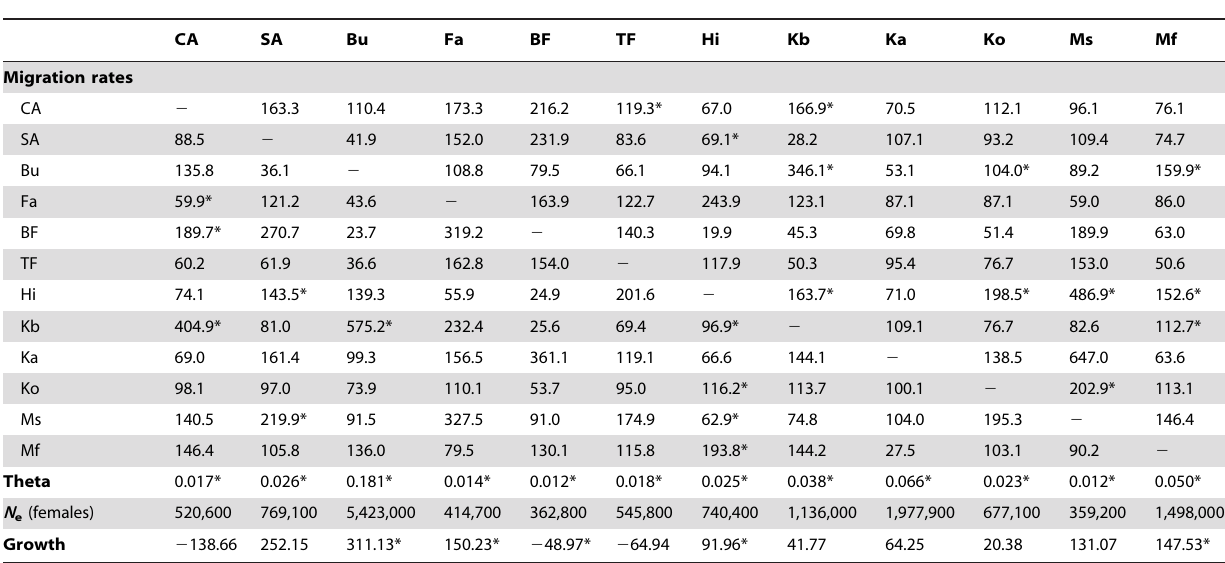
Migration rates: numbers indicate the gene flow from each population group (as indicated in the first column) into the other populations (as indicated in the first row); for instance, 88.5 would be the migration rate from Shuwa Arabs into Chad Arabs. Population codes are as indicated in Table 1. Stars indicate estimates that have to be taken with care due to limited sample sizes (as inferred by Lamarc).